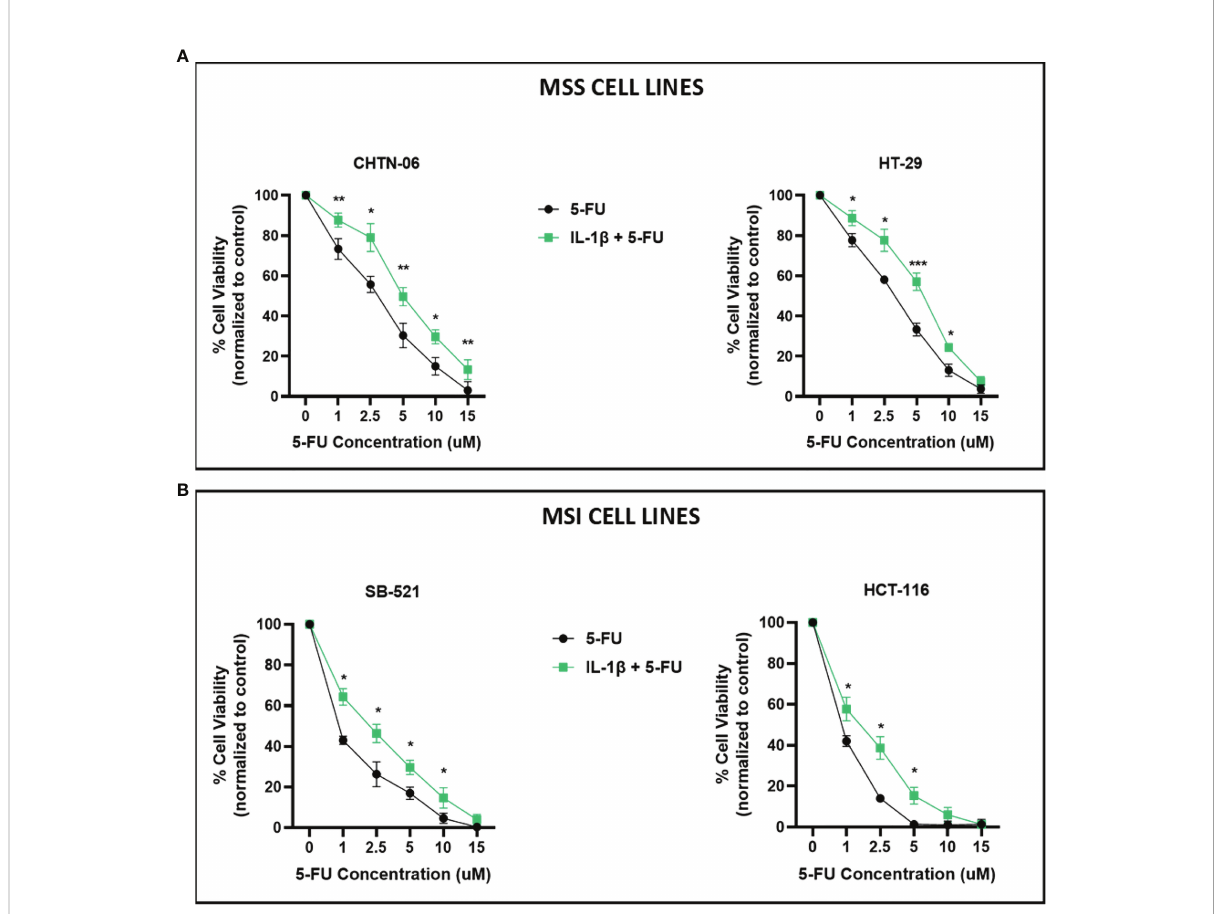
FIGURE 3 IL-1 b decreases sensitivity to 5-FU treatment. Cell viability following treatment with 5-FU, in the presence or absence of IL-1 b , was determined by MTS assay. Cells were seeded in media containing 10 ng/ml of IL-1 b and then treated with increasing concentrations of 5-FU and incubated for 72 hours. (A) CHTN-06 AA cell lines, MSS; HT-29 CA cell line, MSS; (B) SB-521 AA cell line, MSI; HCT 116 CA cell line, MSI. Data are representative of three independent experiments. Error bars represent SEM. *p < 0.05, **p < 0.01, ***p <